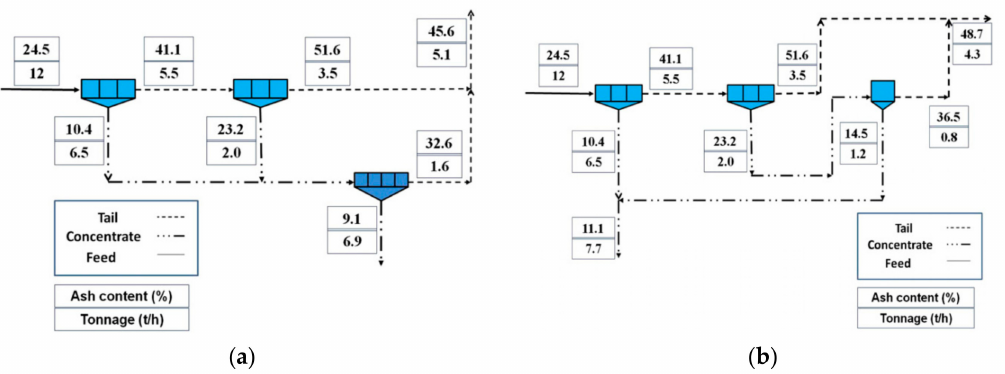
Figure 9. Comparison of flotation circuit design: ( a ) design and ash contents of the initial circuit, ( b ) design and ash contents of the new circuit, adapted from Pirouzan et al.